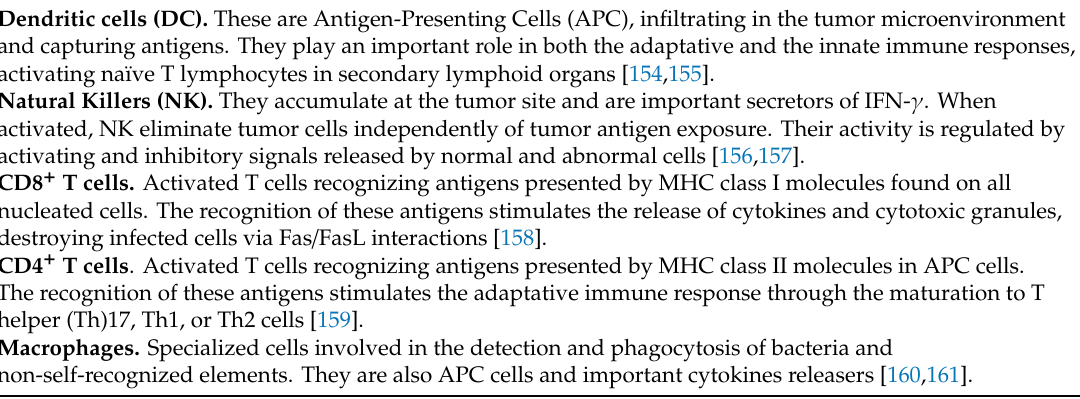
Table A2. Cells involved in the immune